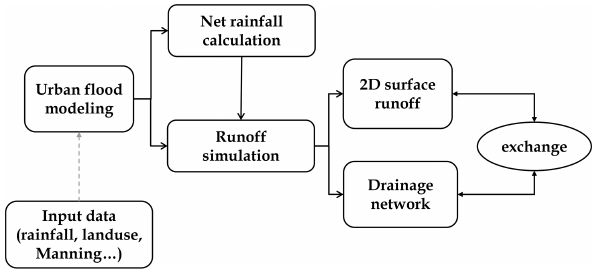
Figure 3. Key components of urban flood